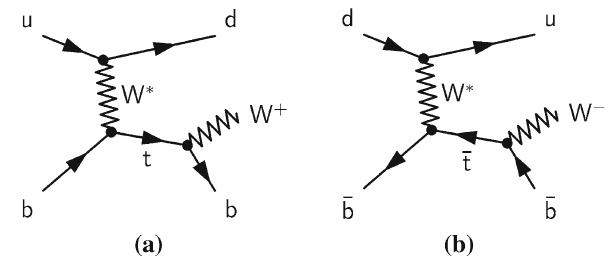
Fig. 1 Representative leading-order Feynman diagrams for a single top-quark production and b single top-antiquark production via the t - channel exchange of a virtual W ∗ boson, including the decay of the top quark and top antiquark,